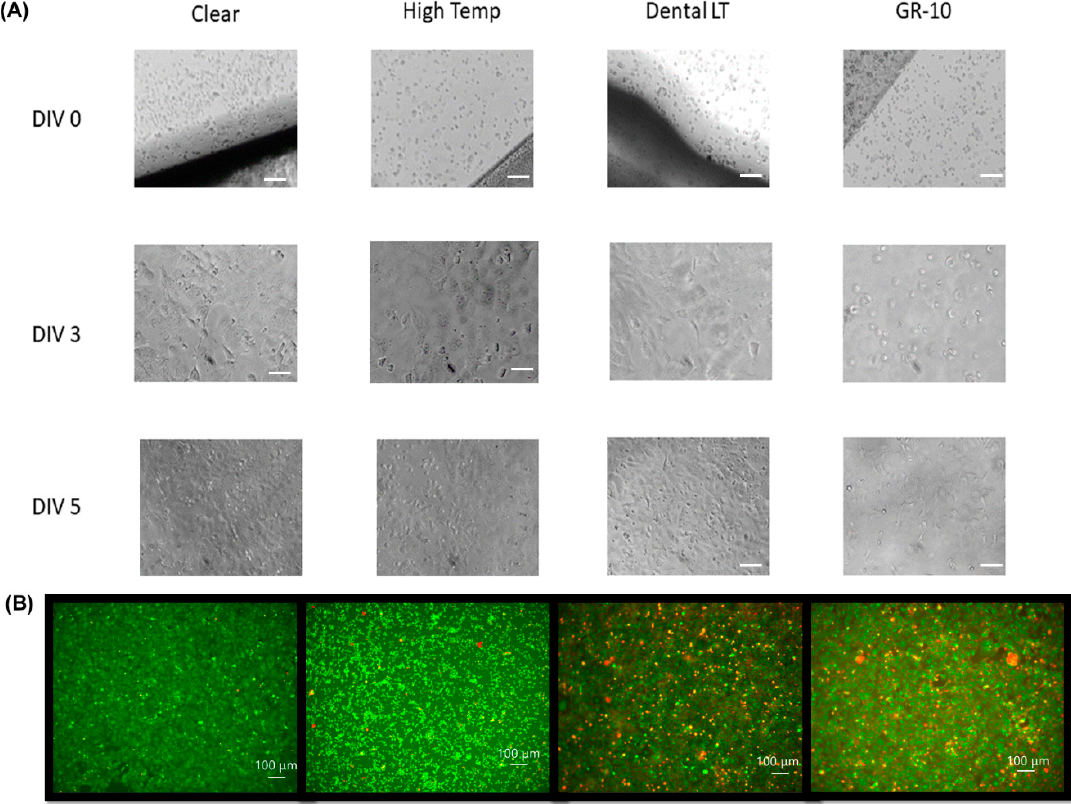
Figure 4. ( A ) Images of HL1 cell growth over the course of 5 days. Clear Resin, High Temp Resin, and Dental LT Resin all demonstrated expected cell growth and matting. The GR-10 resin, however, had extensive cell death with minimal growth. Confluency, or full cell coverage of the surface, is reached after DIV 5 (five days in vitro). After this time, the cells begin to overgrow and die. ( B ) Live / dead fluorescence imaging of the HL-1 cells on top of the Clear Resin, High Temp Resin, Dental LT Resin, and the GR-10 resin. The cells show excellent viability on both Clear Resin and High Temp Resin, but poor viability on Dental LT Resin and the GR-10 resin. All scale bars are 100 µm.